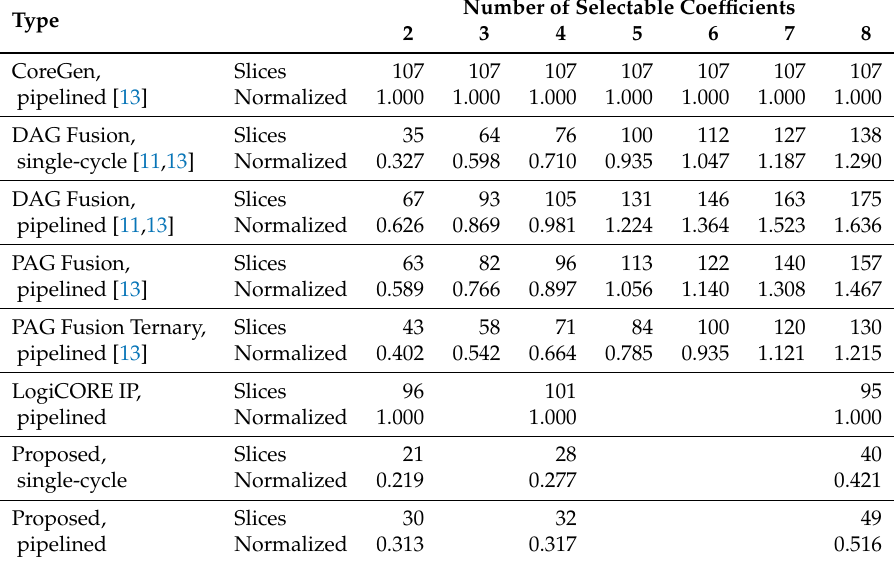
Table 13. Slice utilization for directed acyclic graph (DAG) fusion [11,13], pipelined adder graph (PAG) fusion [13] and proposed (16 × 16)-bit KCMs with two to eight selectable coefficients. DAG fusion and PAG fusion units are normalized to CoreGen as presented in Möller et al. [13], proposed units are normalized to a LogiCORE IP multiplier-based unit.